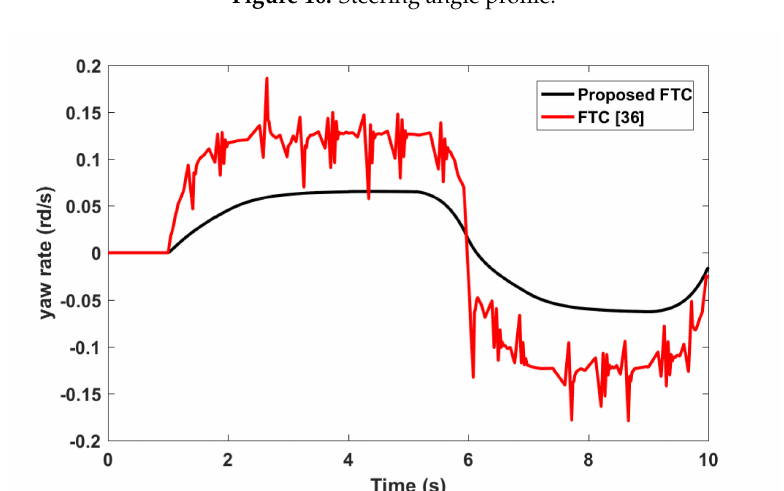
Figure 16. Steering angle profile.